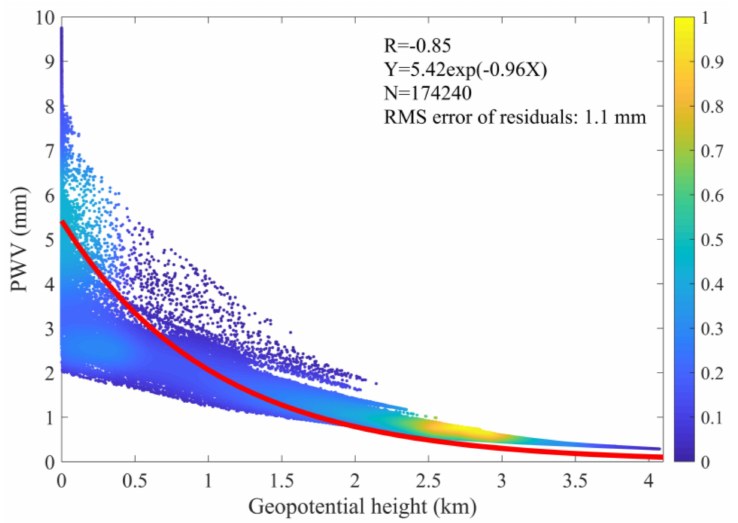
Figure 2. Regression analysis between the PWV and geopotential height over Antarctica using ERA5 data in 2018 (color indicates the relative density of